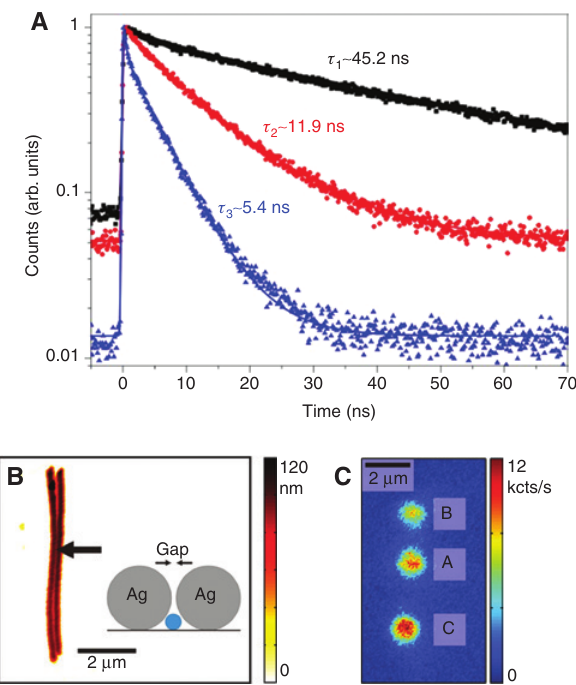
Figure 5: (A) Lifetime measurements of one NV center when located on the glass substrate (black) after coupling to a single nanowire (red) and after locating in the gap between two nanowires (blue). (B) AFM topo- graphy image of two parallel nanowires (the black arrow indicates the location of the NV center) and sketch of the system in the transverse plane. (C) Fluorescence image of the dual wire structure when the NV center is continuously excited. All graphs are taken from Ref.